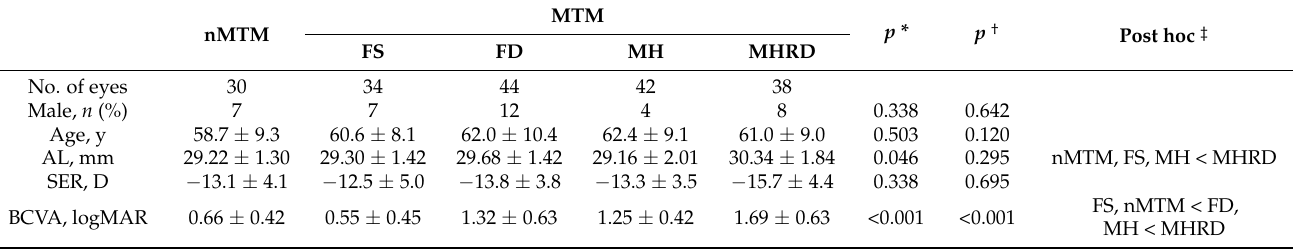
Table 1. General characteristics among highly myopic eyes with different grades of